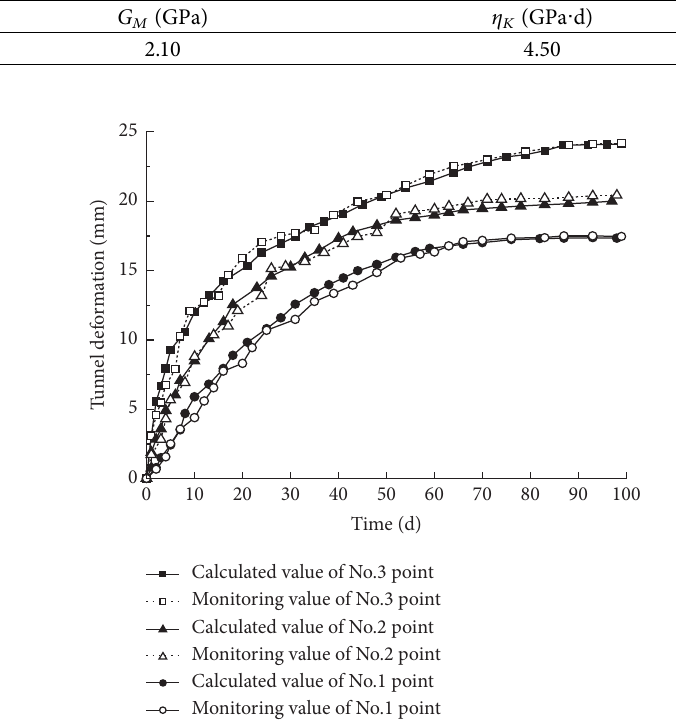
Figure 10: Comparison between the calculated value and the measured value.